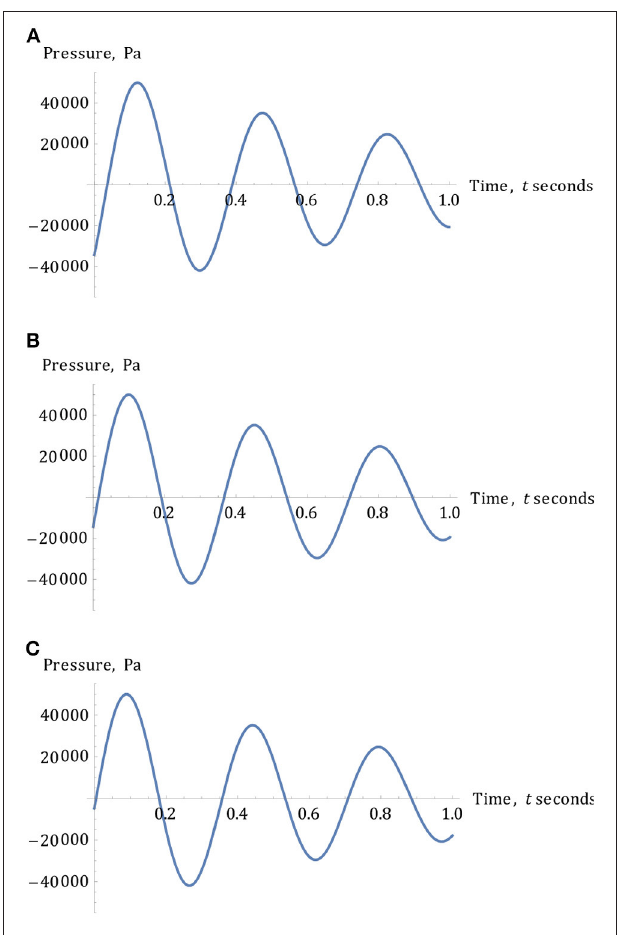
FIGURE 11 | (A) The variation of wave-pressure vs. time for a wave-velocity of 4 m/s. (B) The variation of wave-pressure vs. time for a wave-velocity of 10 m/s. (C) The variation of wave-pressure vs. time for a wave-velocity of 30 m/s.